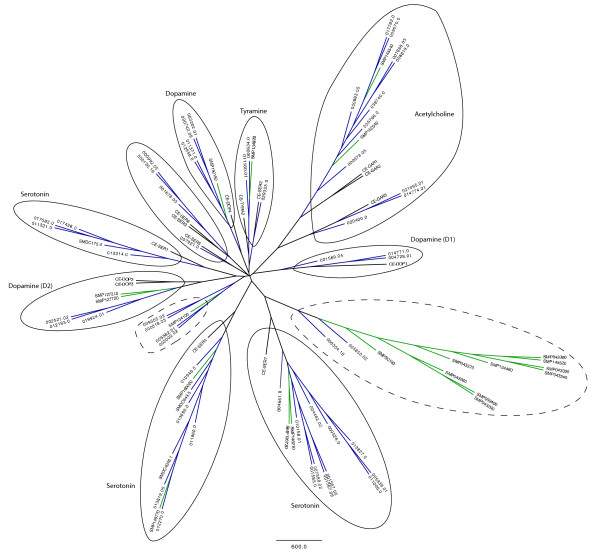
Aminergic receptors: S. mediterranea and S. mansoni. Neighbor-joining tree (bootstrap value = 500) of putative aminergic GPCRs. Included in this analysis are 21 (of 24) S. mansoni and 57 (of 66) S. mediterranea full-length and near full-length aminergic receptors, alongside 14 known C. elegans amine receptors. The latter grouping includes receptors that respond to tyramine, octopamine, dopamine, serotonin, and acetylcholine [97]. Branch lengths are scaled to bootstrap support, branches terminating in Schistosoma receptors are shown in green, and branches terminating in Schmidtea receptors are shown in blue. Flatworm receptors are outlined (solid lines) and classified by ligand with respect to their nearest-related C. elegans homologs. Two diverged flatworm-specific receptor groupings are outlined with a dashed line.